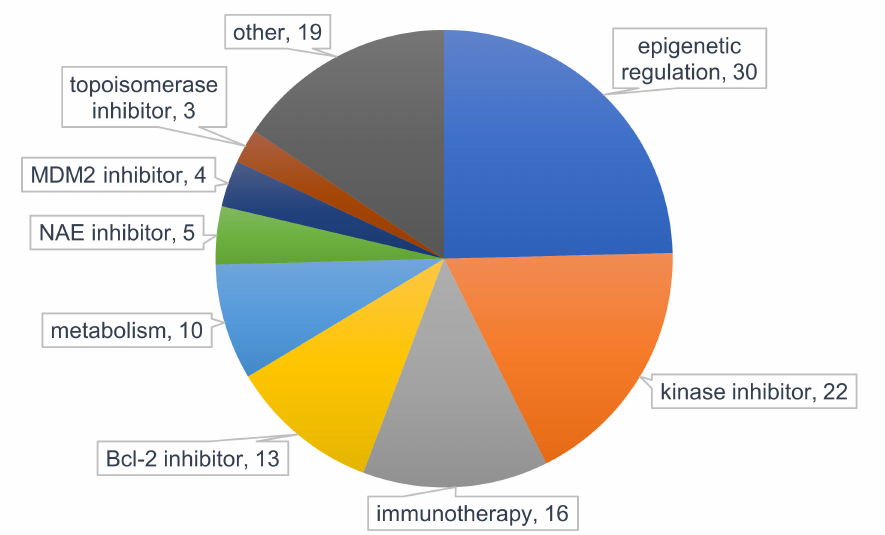
Figure 4. Pie chart presenting the classification of interventions for AML therapy evaluated in clinical trials. Data was obtained from ClinicalTrials.gov and filtered for “recruiting” and “active, not recruiting” status in adult and elderly AML and study phase (1b-3) with start date from 1 January 2018. Numbers present frequency within 88 studies. * other = frequency < 3 include dihydroorotate dehydrogenase (DHODH) inhibitor, proteasome inhibitor, p53 activator, hedgehog signaling inhibitor, CDK inhibitor, E-selectin inhibitor, nuclein export inhibitor, menin-MLL binding interaction inhibitor, CXCR4 antagonist, proteasome inhibitor, corticosteroid, thrombopoietin receptor agonist, and isoprenyl transferase inhibitor. MDM2 = mouse double minute 2 homolog, NAE = NEDD8-activating enzyme, Bcl-2 = B-cell lymphoma